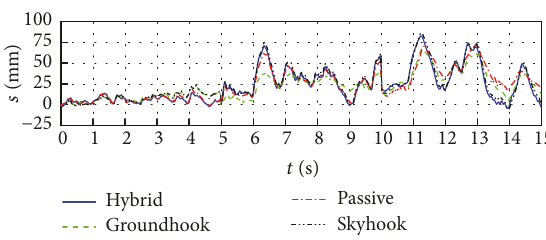
Figure 11: Comparison of the suspension